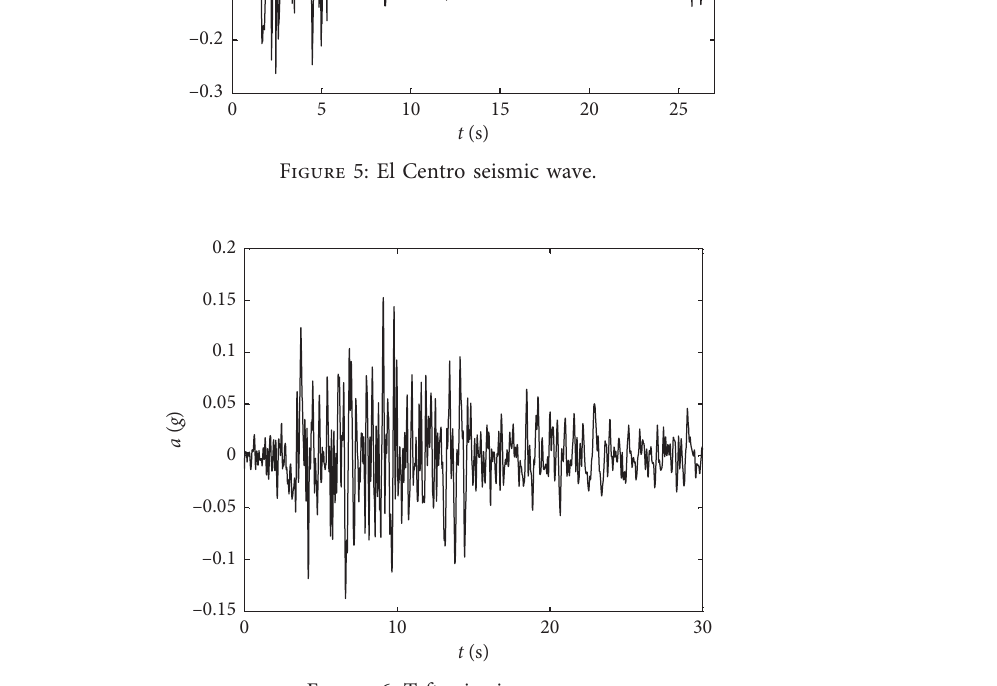
Figure 6: Taft seismic wave. Table 1: Characteristics of seismic